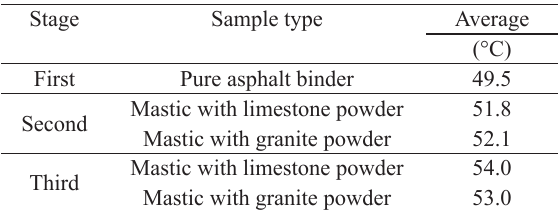
Results of the softening point